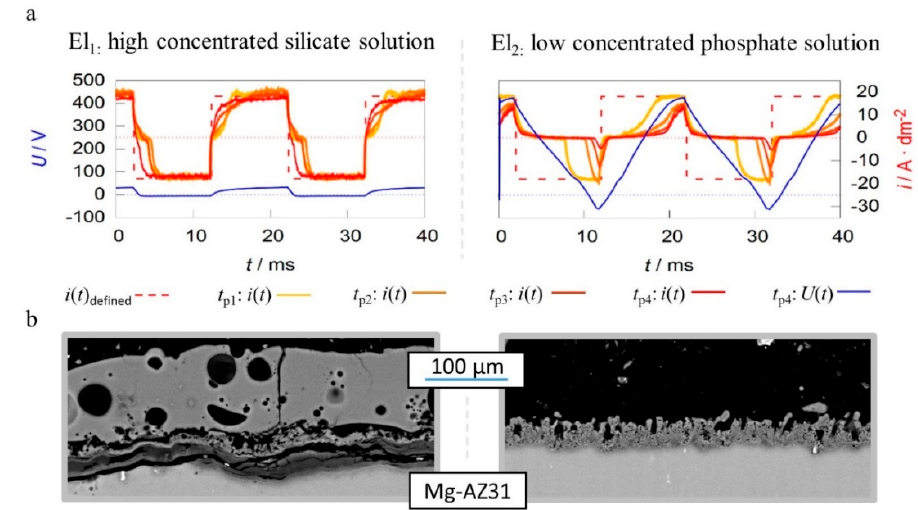
Figure 8. Pulse shape development of current-controlled PEO experiments for different process times ( t p1–4 = 1, 5, 10 and 20 min) under identical experimental conditions in two different alkaline electrolytes El 1/2 ( a ) SEM-micrographs of the resulting layers after 22:30 min of treatment time ( b ).